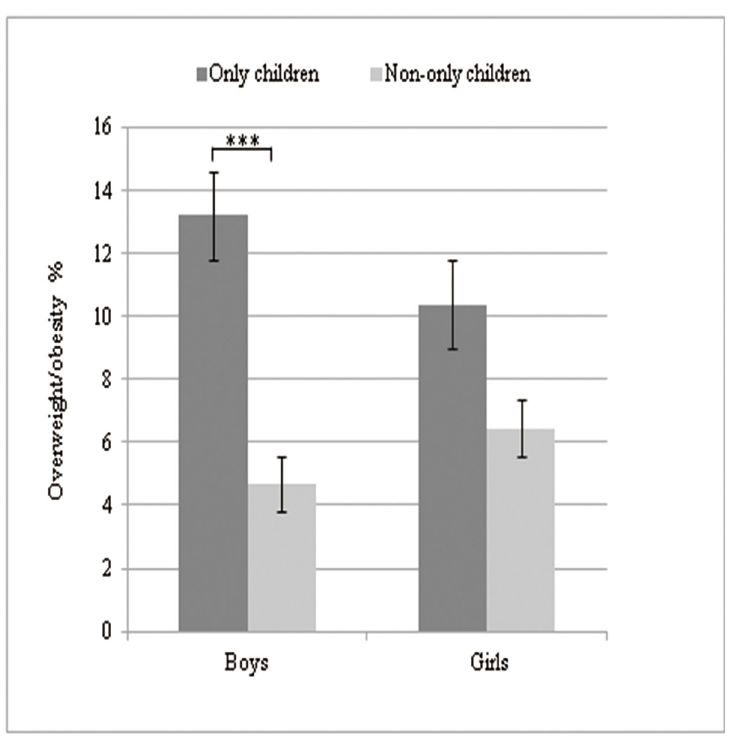
Fig 1. Gender-specific prevalence of overweight/obesity among boys (n = 579) and girls (n = 769), stratified by existence of siblings.